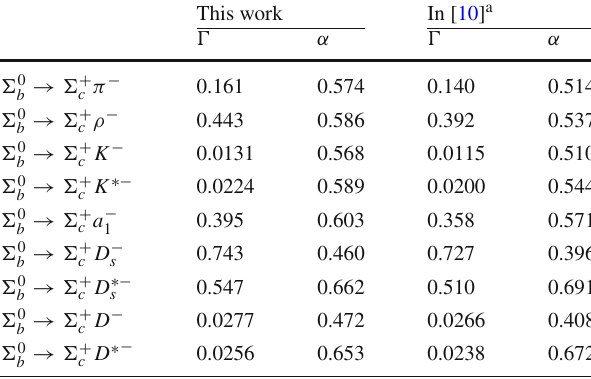
Table 5 The (cid:3) b → (cid:3) c form factors given in the three-parameter form